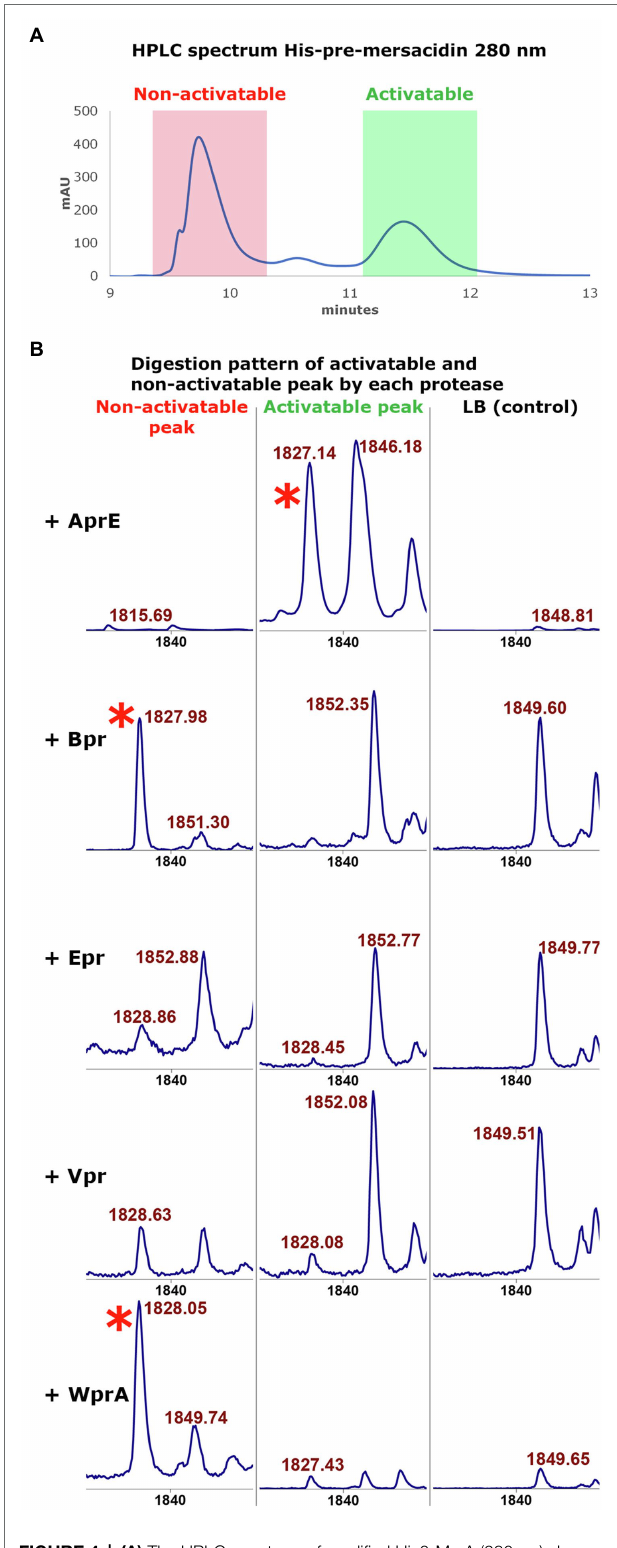
FIGURE 4 | removal of the leader peptide. The peak with a higher retention time (green) contains fully modified His6 MrsA, which can be activated by removing the leader peptide. Both peaks were collected to use in digestion experiments with the ATCC 6633 proteases. (B) The activatable and non- activatable peak were each digested, respectively, with AprE, Bpr, Epr, Vpr, and WprA. The activatable peak digested with AprE has antimicrobial activity and produces a peak with the mass of mersacidin, mersacidin + Na and mersacidin +K (1826 Da, 1848 Da, and 1865 Da (Herzner et al., 2011), red asterisk). However, the non-activatable peak also produces a large peak of 1826 Da when digested by Bpr and WprA that lacks antimicrobial activity. Since Bpr and WprA do not produce this peak when digesting the fully modified His6-MrsA, formation of ring A probably inhibits proteolytic